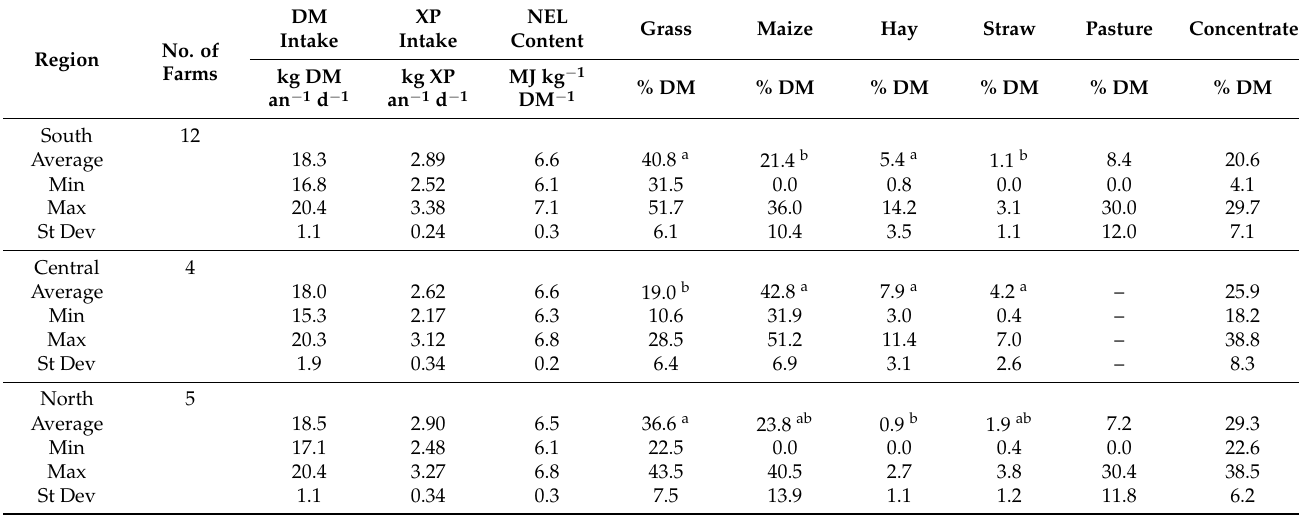
Table 5. Analysed farm descriptions: milking cow